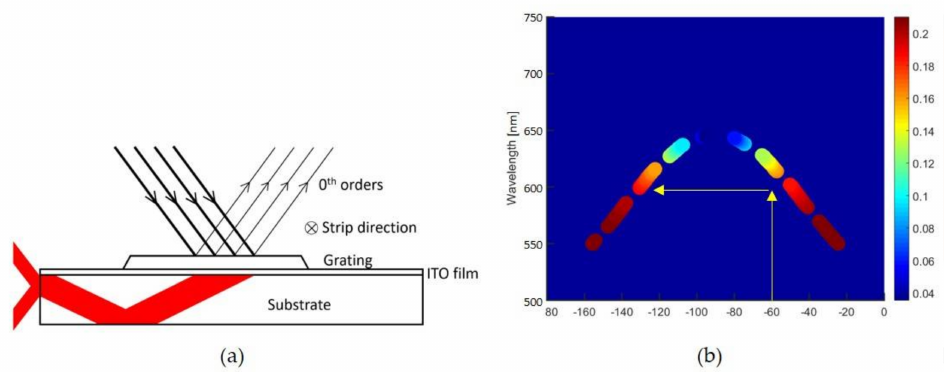
Figure 6. The geometry of the sample affects the output; this is shown for parallel rays interacting with the grating ( a ). Note, that depending on the incident beam positions relative to the substrate edge there are three possible scenarios, these rays may either hit the corner and split between upward and downward as shown in ( a ), or propagate in one of two directions, upward or downward. If the beam goes upward it makes a gap in the down side ( b ). Map ( b ) is an angular extension of Figure 8b SIM TM 40 ◦ , as an example; the gap at − 60 ◦ is pointed by